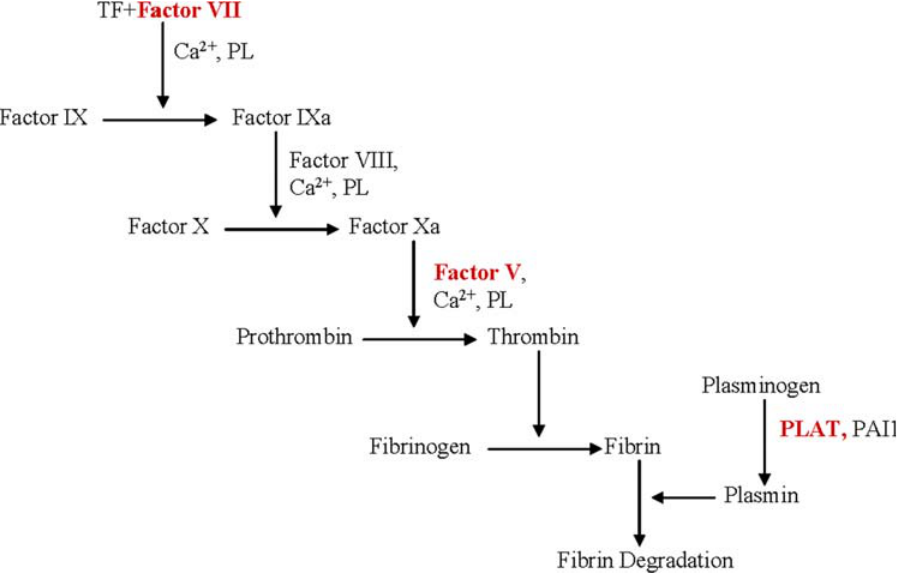
Figure 2. Associated genes in the complement and coagulation pathway subset. This branch of the complement and coagulation cascade had a cluster of three genes with significant results ( a , 0.05) at either the allele or genotype level (labeled in red). In addition to these genes we also genotyped markers in PAI1 from this branch and two genes from other branches of the complement and coagulation cascade (Soluble mannose- binding lectin 2 (MBL2), factor II (FII)); however, no markers in these genes were significant.